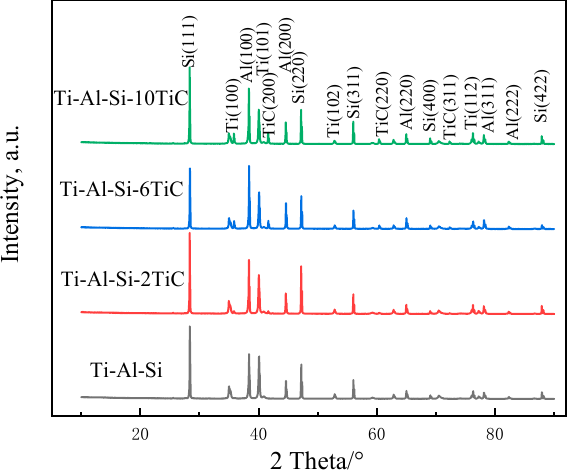
Figure 2. XRD patterns of Ti-Al-Si- x TiC powders after mechanical mixing.